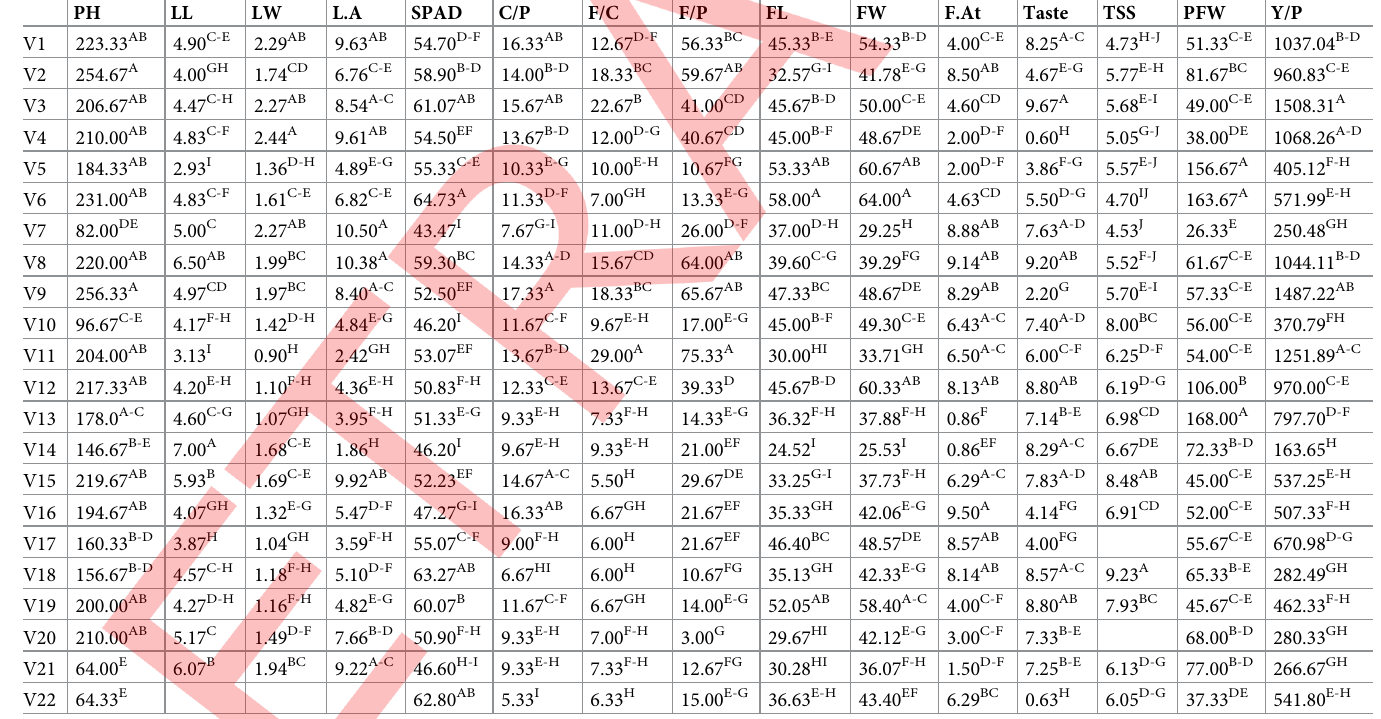
Table 1. Comparison of traits among 22 varieties, n = 9, average values are included in the table for each